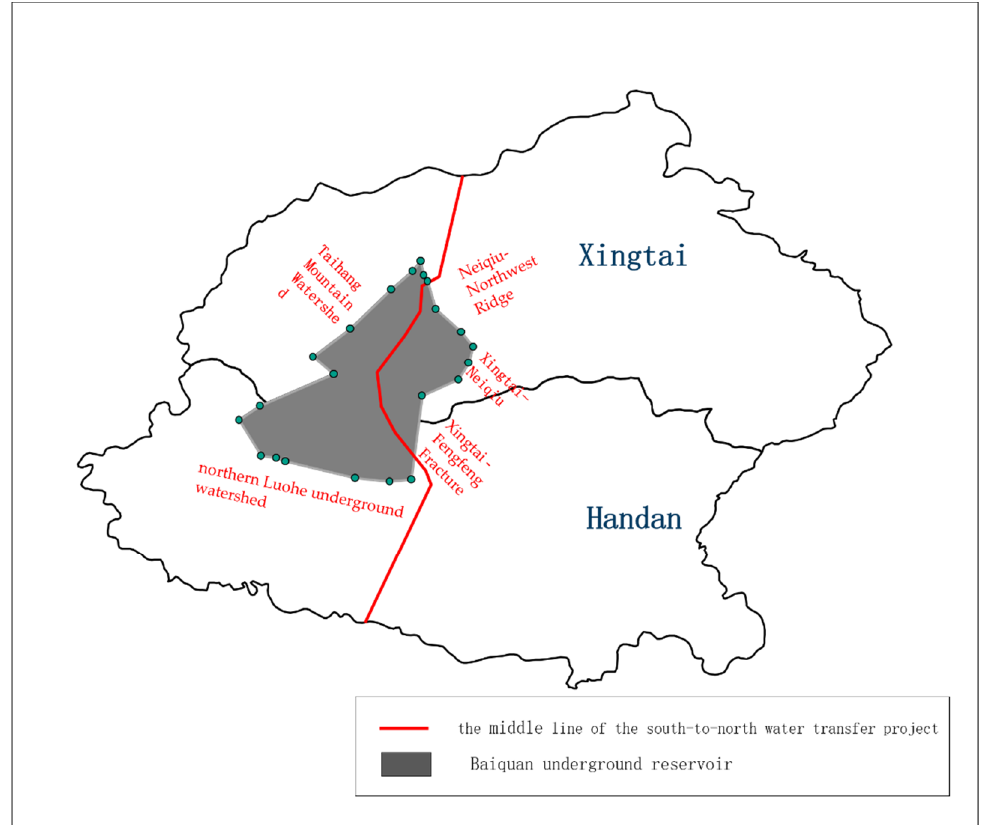
Figure 1. Location diagram of the Baiquan Underground Reservoir.